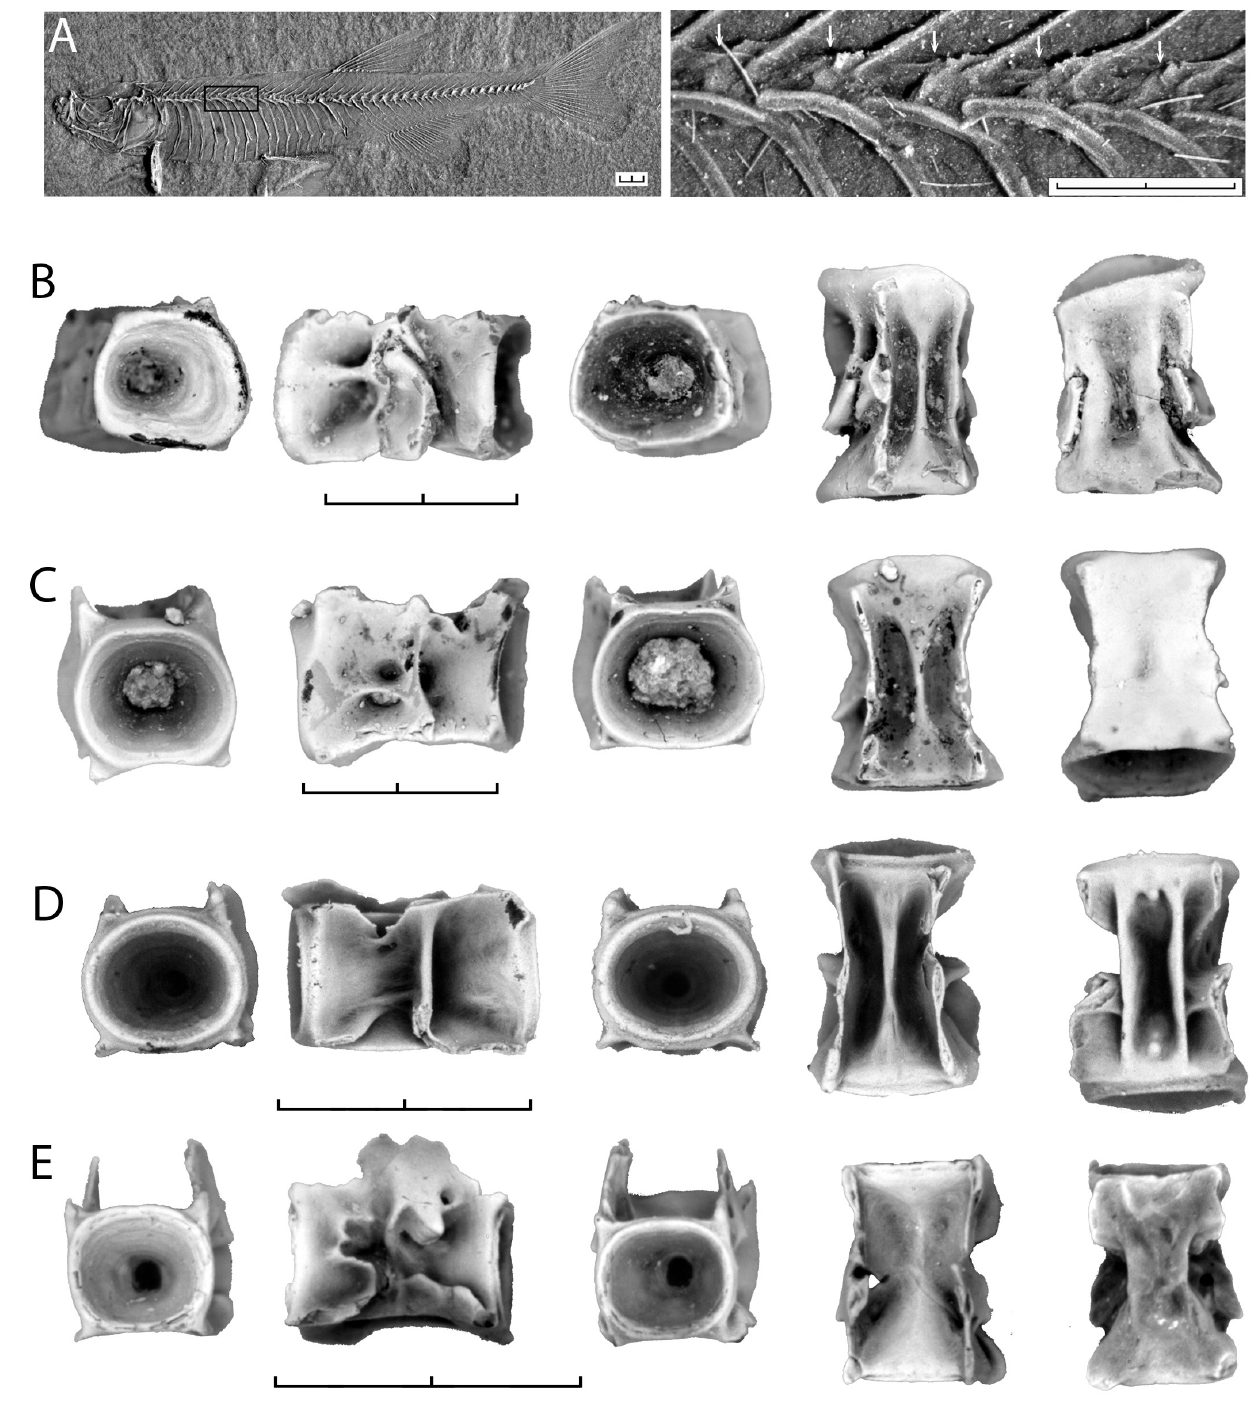
Figure 10. Centrum morphotype HvA from the Milk River Formation compared with vertebrae of the type specimen of Ostariostoma wilseyi and with specimens from the Belly River Group and Lance Formation. A) Ostariostoma wilseyi skeleton with close-up of the mid-precaudal region of the vertebral column showing proportions of precaudal centra. Arrows indicate the approximate position of the ends of the centra. Photograph of UALVP 52610, cast of type specimen. B, C) examples of centrum morphotype HvA from the Milk River Formation showing variation in the development of the parapophyses: B, mid precaudal centrum with autogenous parapophyses preserved in articulation with the centrum, UALVP 48897; C, posterior precaudal centrum with parapophyses fused to the centrum, UALVP 48895. D) Centrum morphotype HvA from the Belly River Group, specimen TMP 1993.91.29. E) Centrum morphotype HvA from the Lance Formation, uncatalogued UALVP speci - men from Bushy Tail Blowout locality, Lance Formation, Wyoming. Scale bar equals 2